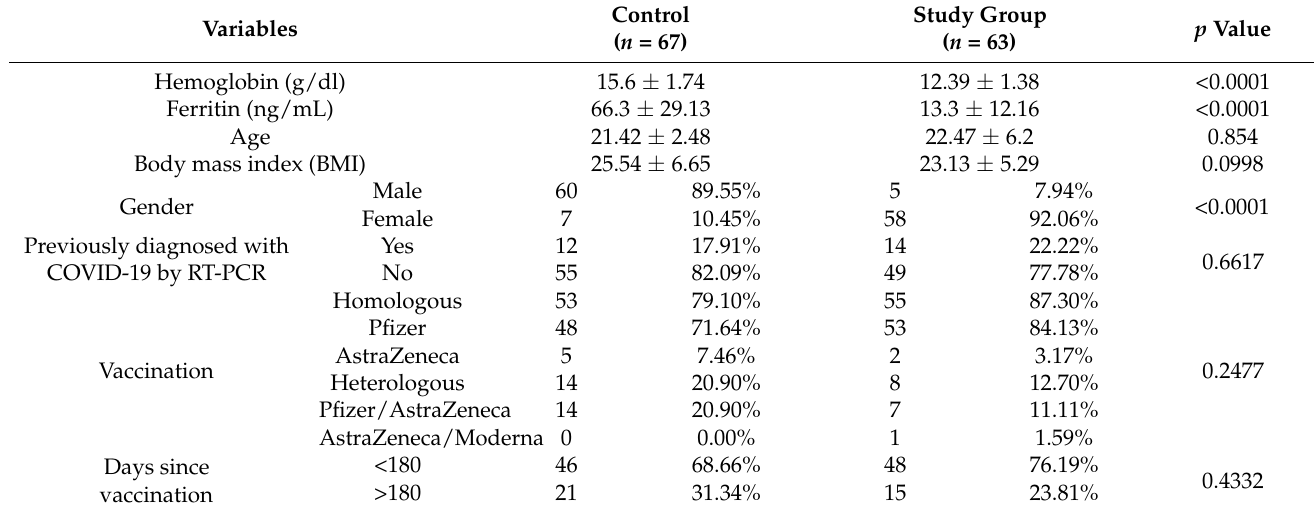
Table 1. Characteristics of control (normal hemoglobin and ferritin) and study group (ID,